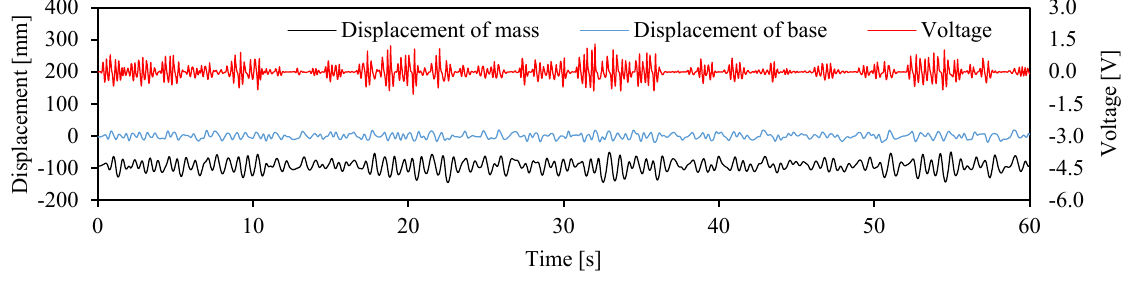
Figure 10. Measurement results yielded by random signal excitation.